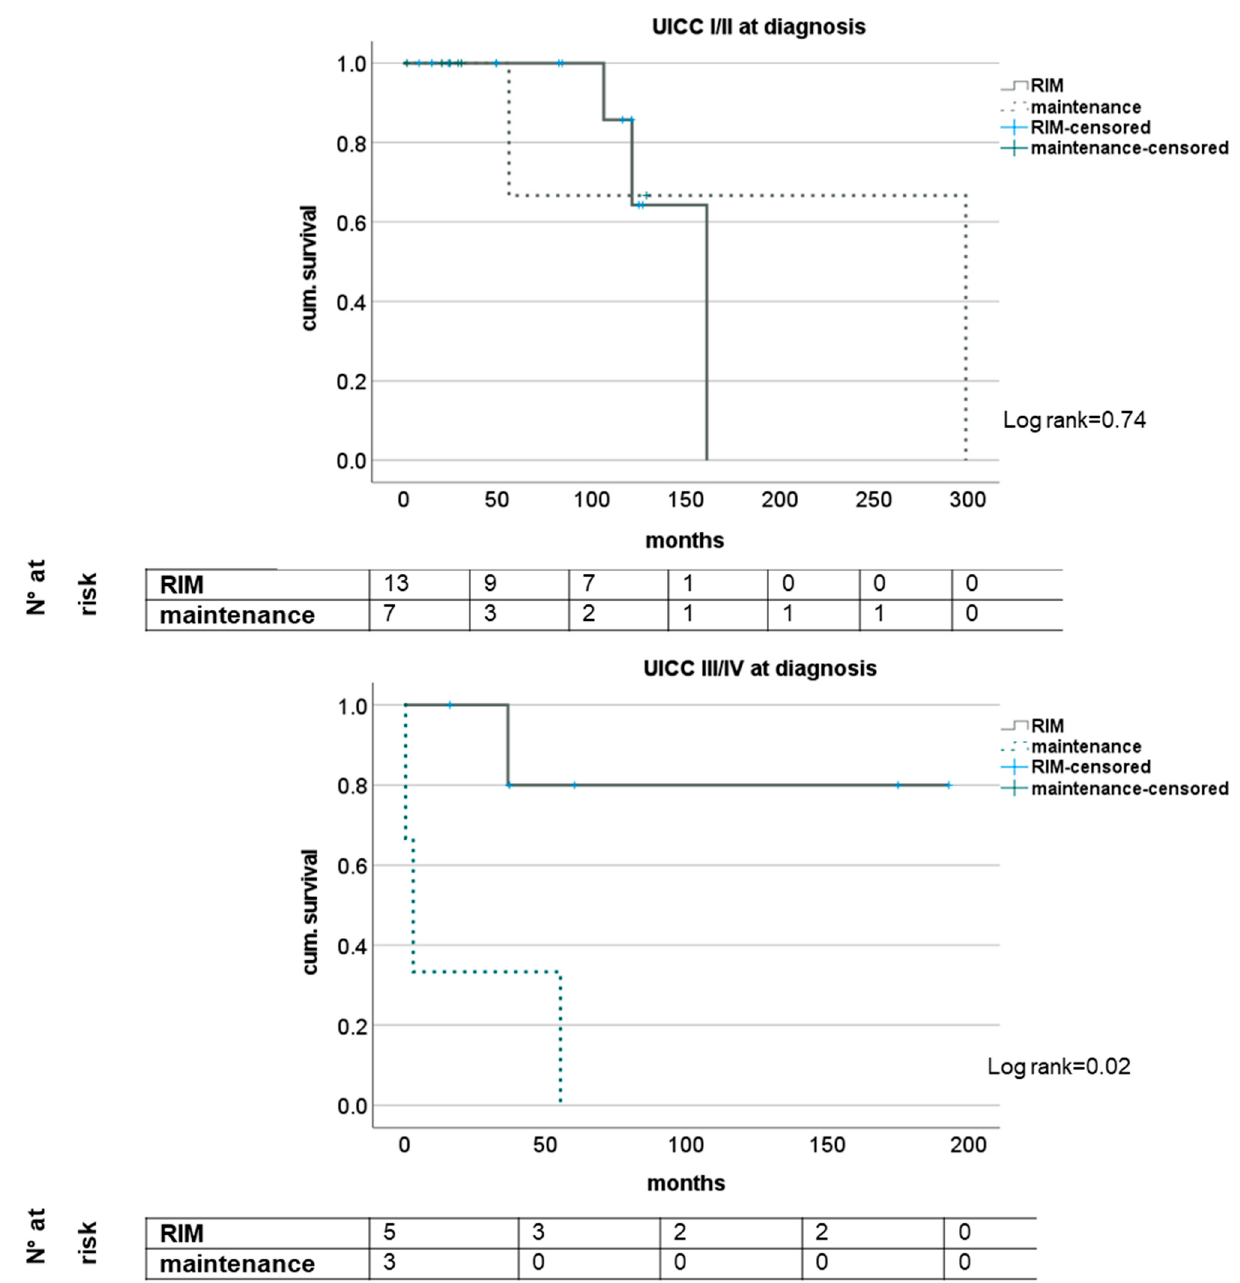
Figure 3. Impact of RIM dependent on tumor stage according to UICC.